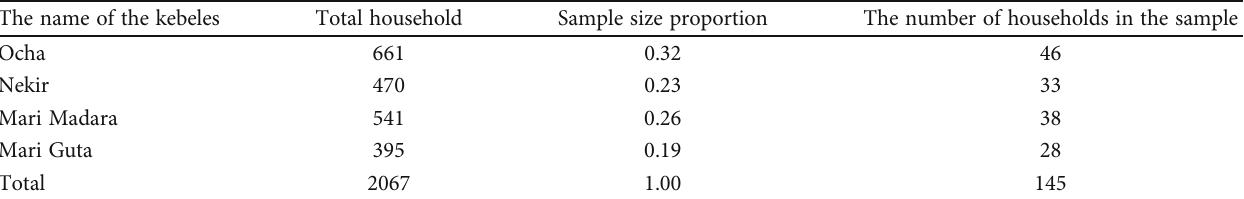
Figure 1: Map of the study area. Table 1: The sample kebeles as well as the total number of